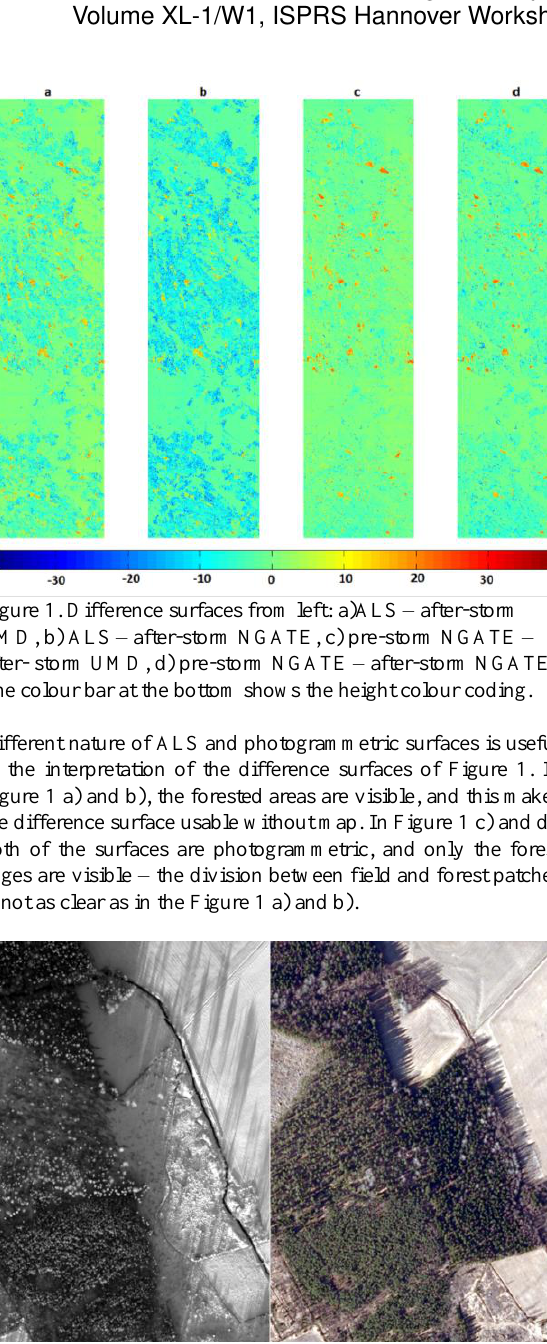
Figure 2. Left: after-storm imagery. Right: pre-storm imagery (Copyright for after-storm aerial images: Blom Kartta Oy©, Copyright for before- storm images: National Land Survey©).